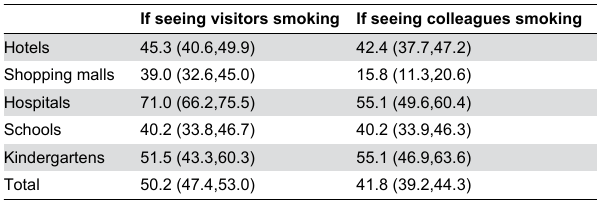
Table 3. The proportion of non-smoking participants selecting “I would stop other people smoking in the workplace” (%).